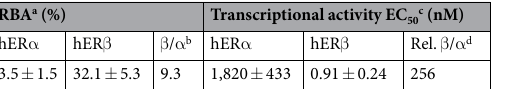
Table 1. Binding affinities and transcriptional activities for ERs and ER β selectivity of compound C-1. Binding affinities for ERs were determined by a fluorescence polarization displacement assay, and are expressed as RBA values compared to the affinity of E2. Transcription activities were determined by a cell-based ERs assay. pGL4.27-(ERE)3-Luc and expression vector containing ER α or ER β were transfected into HEK293T cells. Luciferase activity was measured and the transcriptional activity of each compound was normalized by the hypothetical maximal response of E2 ( = 100). a RBA values were calculated by IC 50 [E2]/IC 50 [C-1] × 100 (RBA of E2 = 100), shown as mean ± SD of three independent experiments, performed in duplicate. b β / α values = ER β - RBA/ER α -RBA (ER β selectivity of binding affinity). c EC 50 values are shown as mean ± SD of three or four independent experiments, performed in duplicate. d Rel. β / α values = {ER β -EC 50 [E2]/ER β -EC 50 [C-1]}/{ER α - EC 50 [E2]/ER α -EC 50 [C-1]} (ER β selectivity of agonistic activity). Detailed information can be found in ref. 27. Abbreviations : EC50 , half maximal (50%) effective concentration; hER , human estrogen receptor; RBA , relative